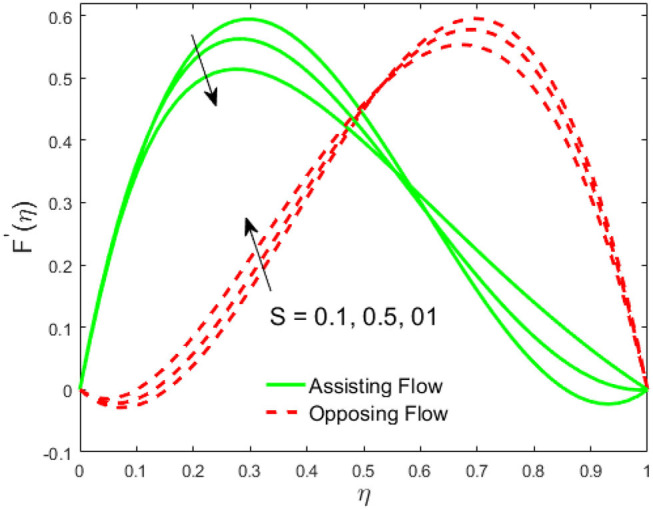
Impact of S on F′(η).